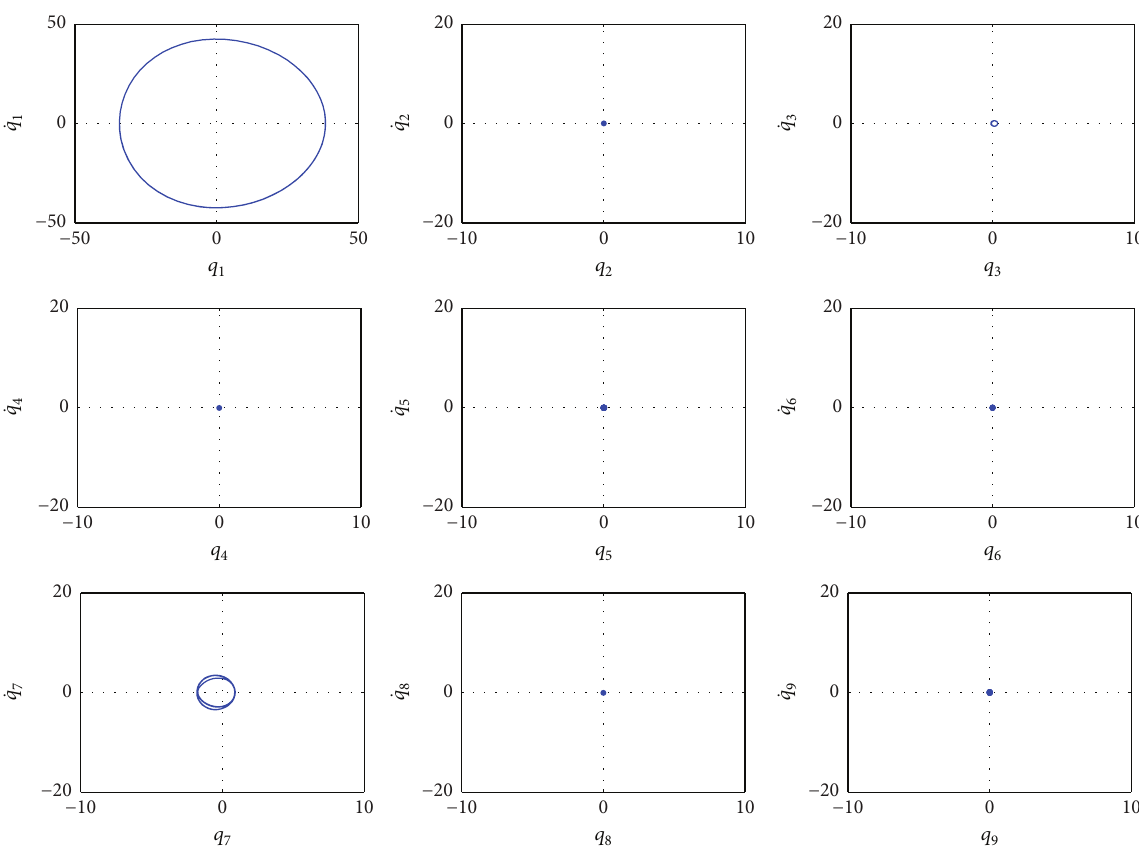
Figure 12: Two-dimensional projections of phase portraits onto the (𝑞 𝑟 , ̇𝑞 𝑟 ) plane, 𝑞 𝑟 (0) = 0.1𝛿 1𝑟 and 𝑁 = 11 .